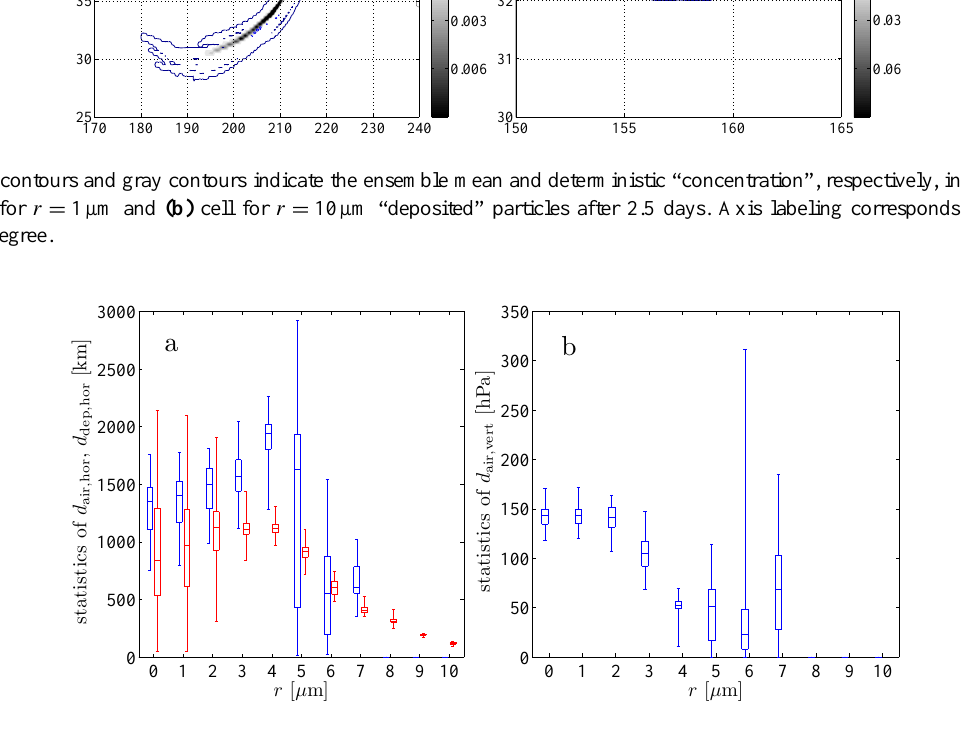
Fig. 8. (a) The horizontal location of the center of mass of the pollutant clouds in the atmosphere (blue) and in the deposition field (red) for the 50 ensemble members after 2.5 days. The radius of the circles are proportional to the standard deviations. DET and CF denotes the deterministic forecast (black) and the control forecast, respectively, and the cyan (yellow) dot with dark edge marks the center of mass and standard deviation of all particles of the 50 ensemble members that remain in the atmosphere (deposit). (b) The mean vertical coordinate of the center of mass of the ensemble members (lines in the boxes) with the mean standard deviation (the bottom and the top of the boxes) (blue), those for the whole ensemble forecast (cyan) and for the deterministic forecast (black).